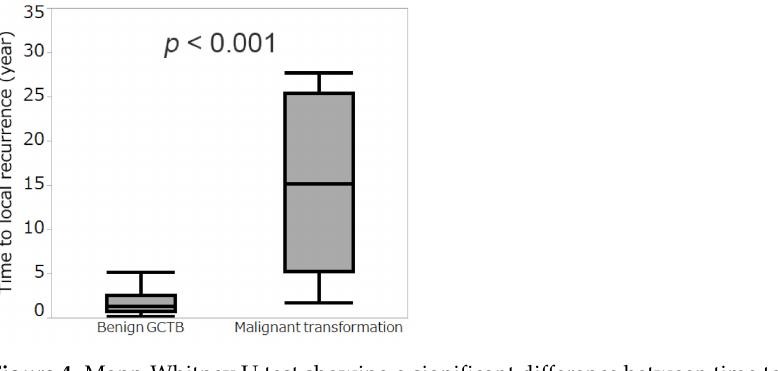
Figure 4. Mann-Whitney U test showing a significant difference between time to local recurrence of benign giant cell tumor of bone (GCTB) and time to local recurrence with malignant transformation ( p <